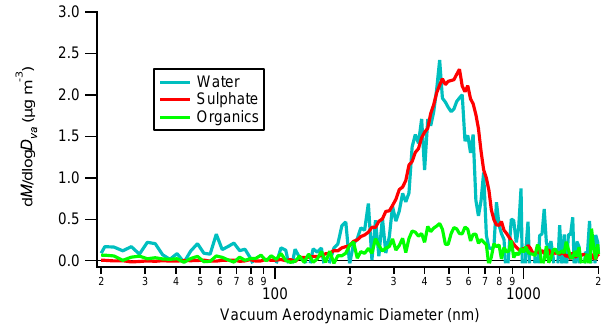
Fig. 7. Mass size distributions averaged over the period from 21 September 2006 to 2 October 2006 having above average sulfate and organics mass concentrations.